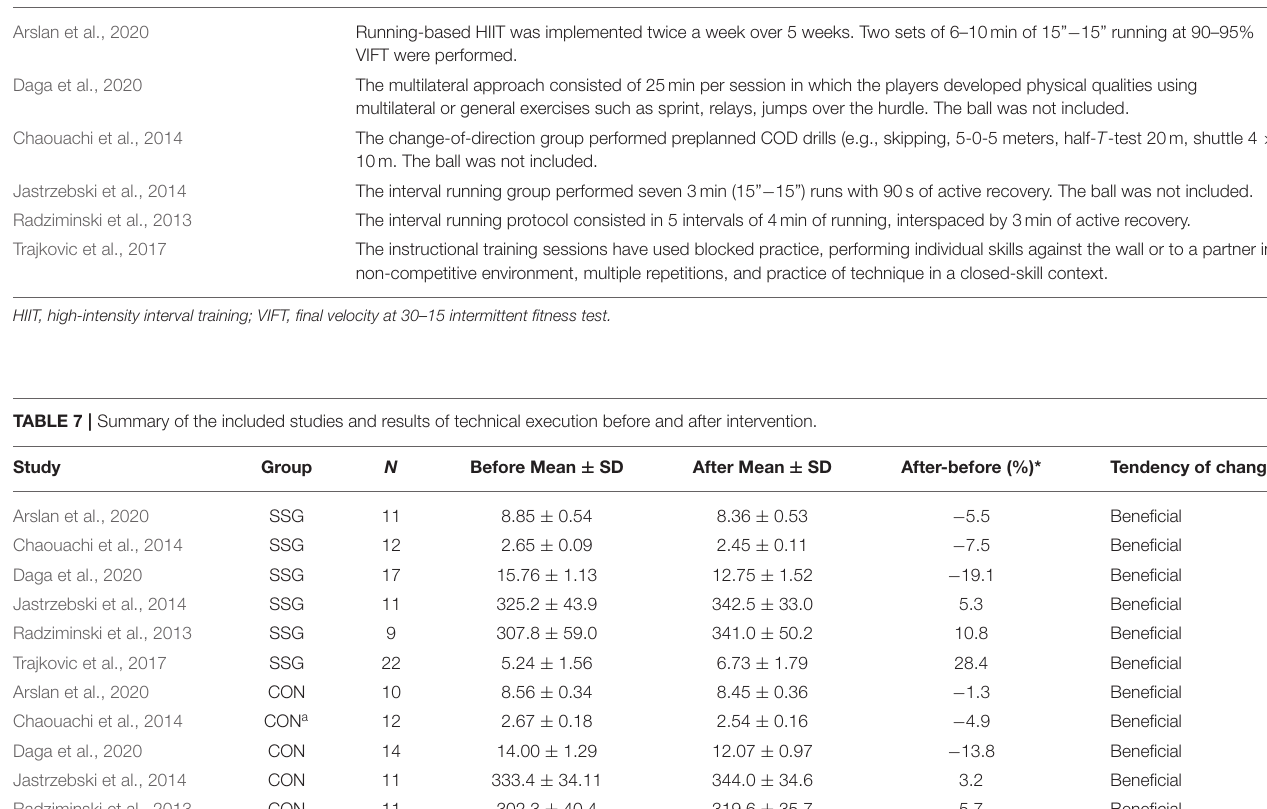
TABLE 6 | Characteristics of the other training programs in the included studies. Study